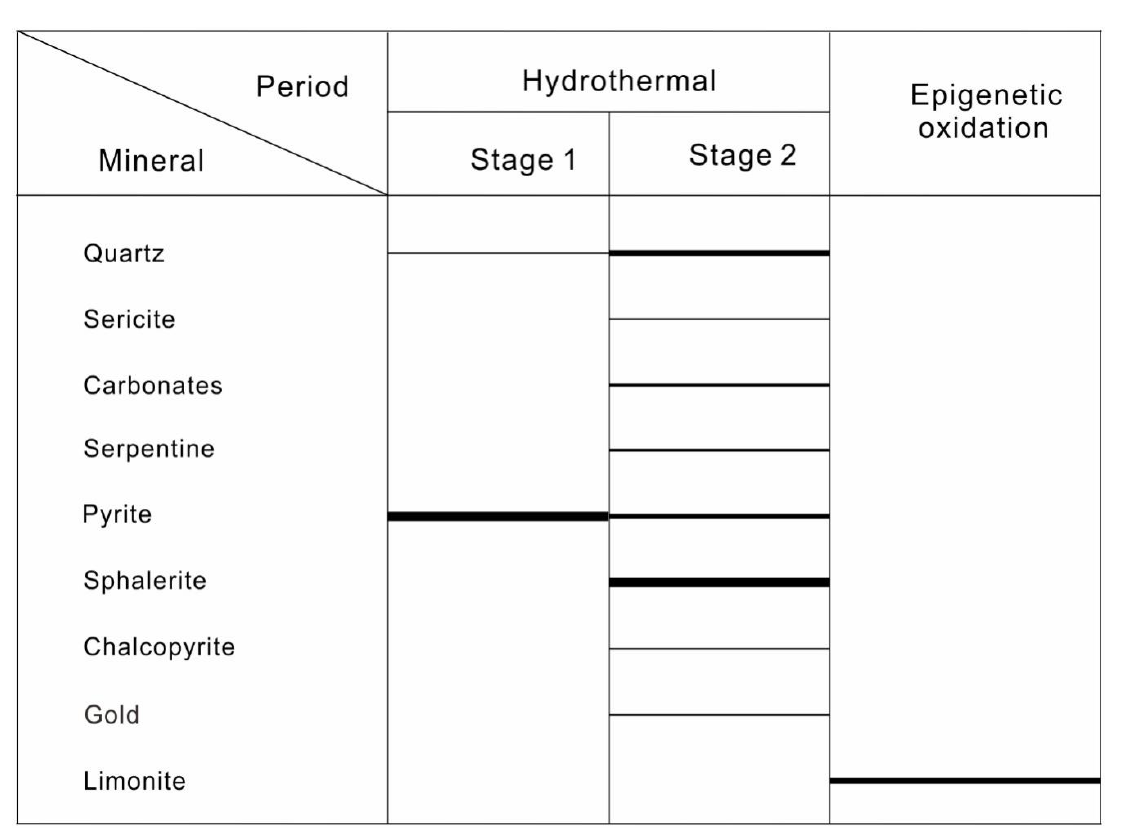
Figure 6. Paragenetic relationship of the minerals at the Liushuping Au–Zn deposit.